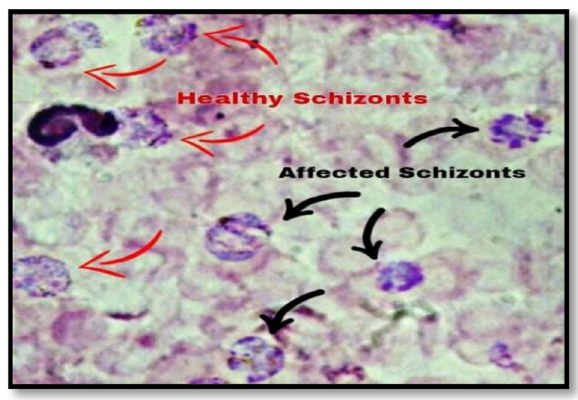
Figure 1: Healthy and a ff ected schizonts/cytotoxic activity under the microscope.